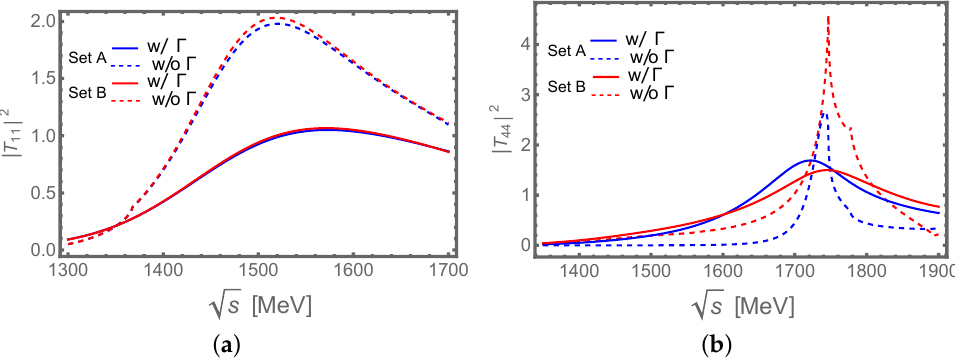
Figure 5. The dashed and solid lines correspond to zero and full widths of the axial-vector mesons in G Cut . ( a ) Modulus square of elastic b 1 π scattering; ( b ) Modulus square of elastic K 1 ( 1270 ) ¯ K